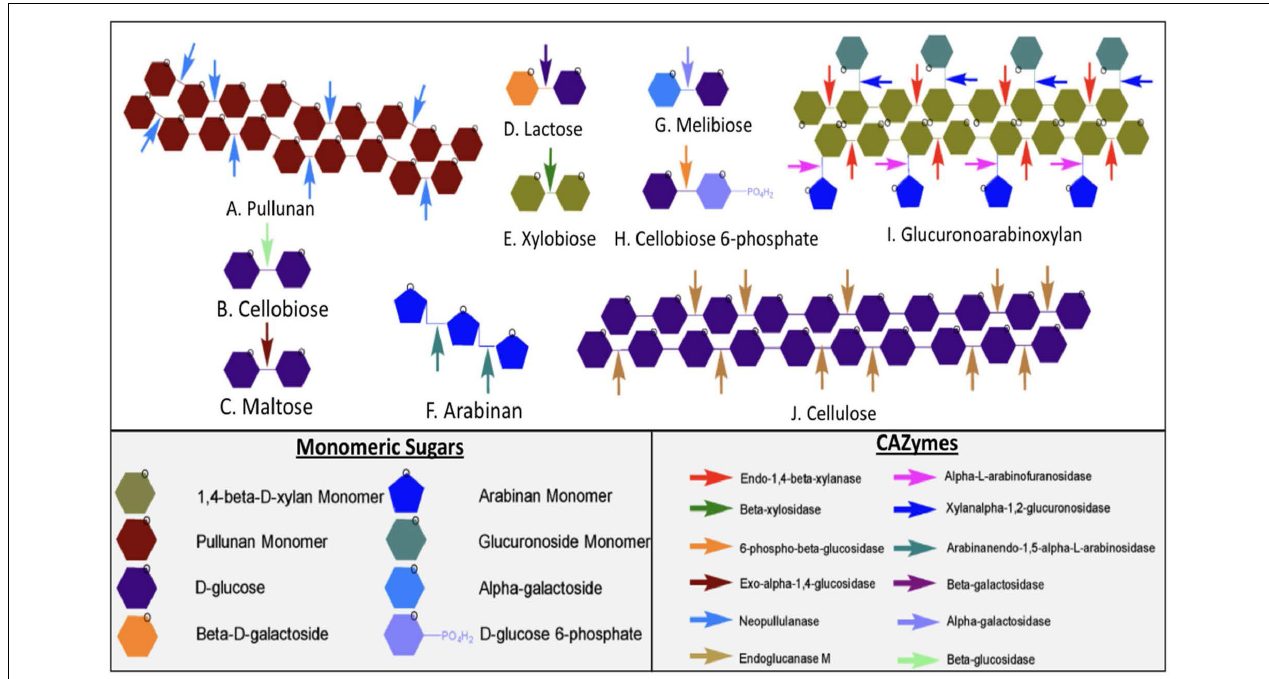
FIGURE 6 | The different active sites of CAZymes and synergy between different enzymes present in Geobacillus sp. WSUCF1. At the top are the different types of sugar complexes represented by hexagons. The arrows are the CAZymes that breakdown different sugar linkages. The sugars are made up of their constituent monomeric sugars. Enzymes that are known to break down complex carbohydrate and dimeric sugars include A, Pullunan; B, Cellobiose; C, Maltose; D, Lactose; E, Xylobiose; F, Arabinan; G, Melibiose; H, Cellobiose 6-phosphate; I, Glucuronoarbinoxylan and J. cellulose.